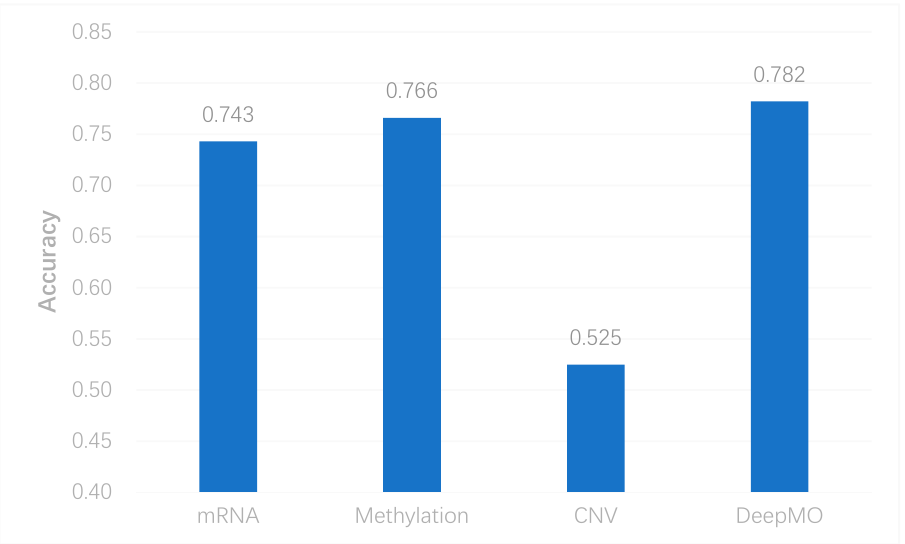
Figure 4. The accuracy by using single omics data and multi-omics data.